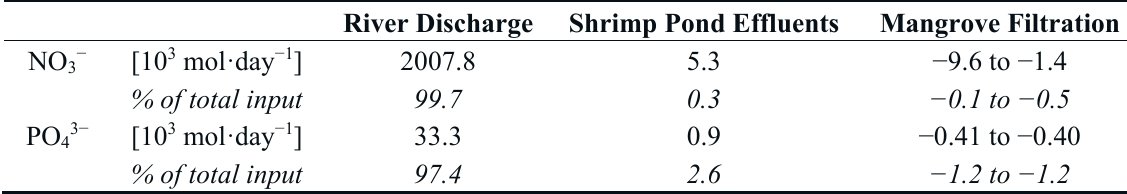
Table 3. Mangrove filtration efficiency for NO 3 − and PO 43 − relative to land-derived riverine input, based on daily fluxes and a mangrove area of 515 ha. Daily nutrient inputs from Kaiser (unpublished [124], but see [50] for seasonal